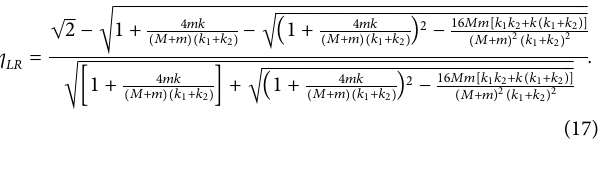
Frontiers in Materials |